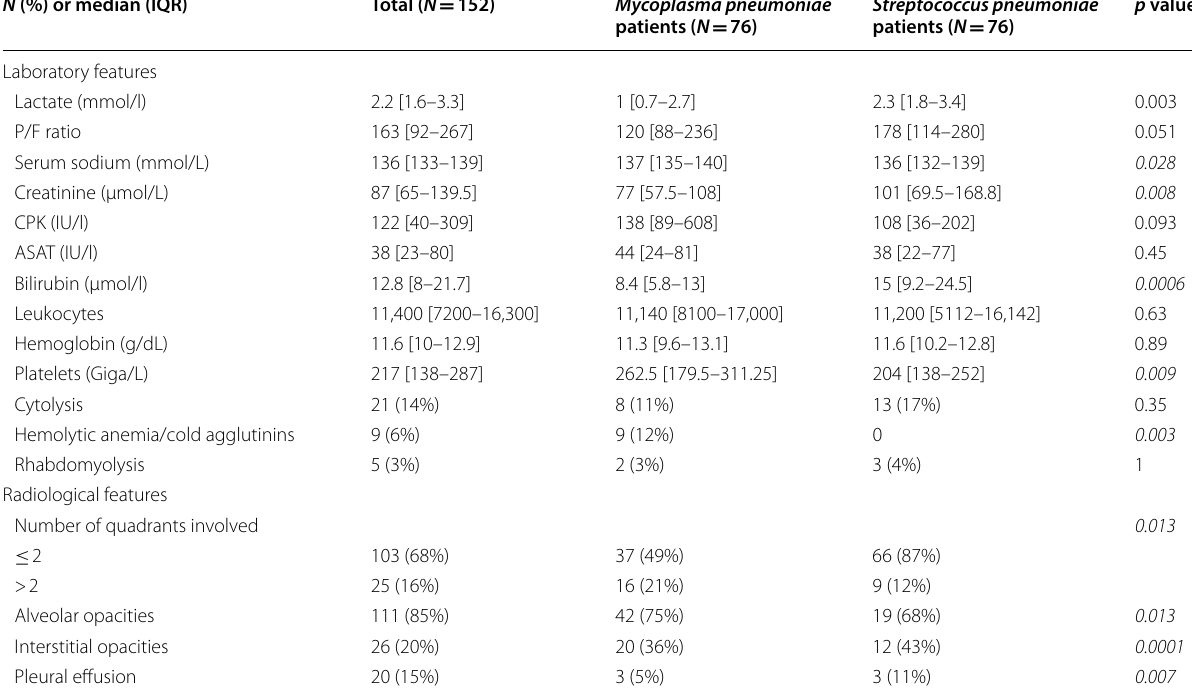
Table 3 Univariate